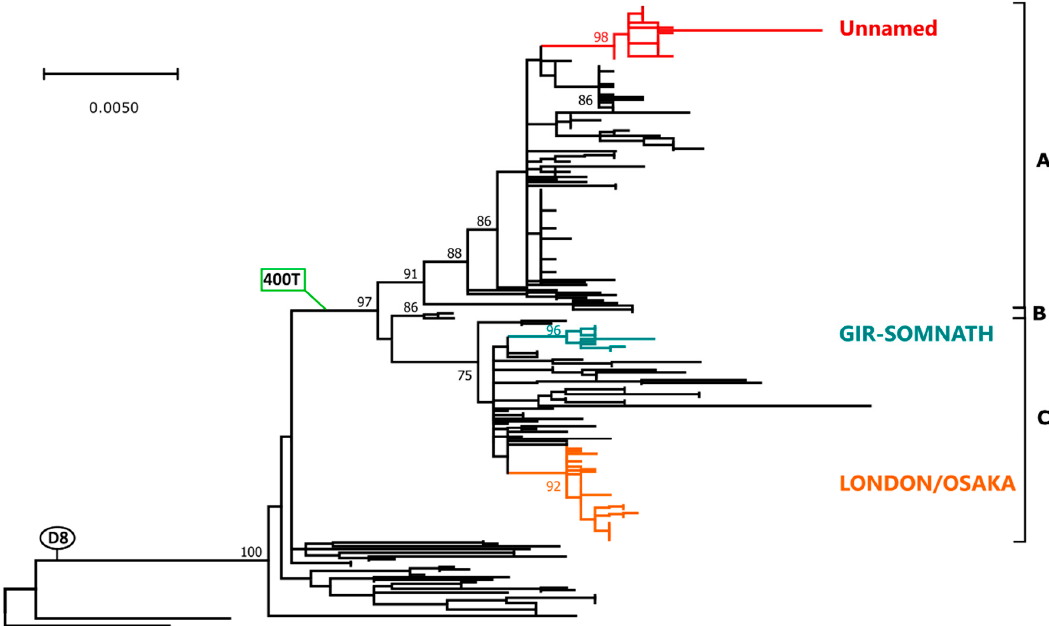
Figure 3. Phylogenetic analysis of genotype D8 H gene. The tree was obtained with the maximum-likelihood method [27], based on the Tamura 3-parameter model [32], identified as the best-fitting model after the model test analysis, using MEGA X [29]. A discrete Gamma distribution was used to model evolutionary rate differences among sites (+G = 0.2684) and branch support (1000 bootstrap iterations [30]) is provided next to nodes. Sequences from genotypes D5 (Bangkok.THA/93/1) and D9 (Victoria.AUS/12.99) were used as outgroup. Branches corresponding to genotype (D8), clade (400T), sub-clades (A, B, C), and clusters considered in this study (Unnamed, GIR-SOMNATH, LONDON/OSAKA) are indicated. Accession numbers of sequences used to generate this tree are available in Figure S4.